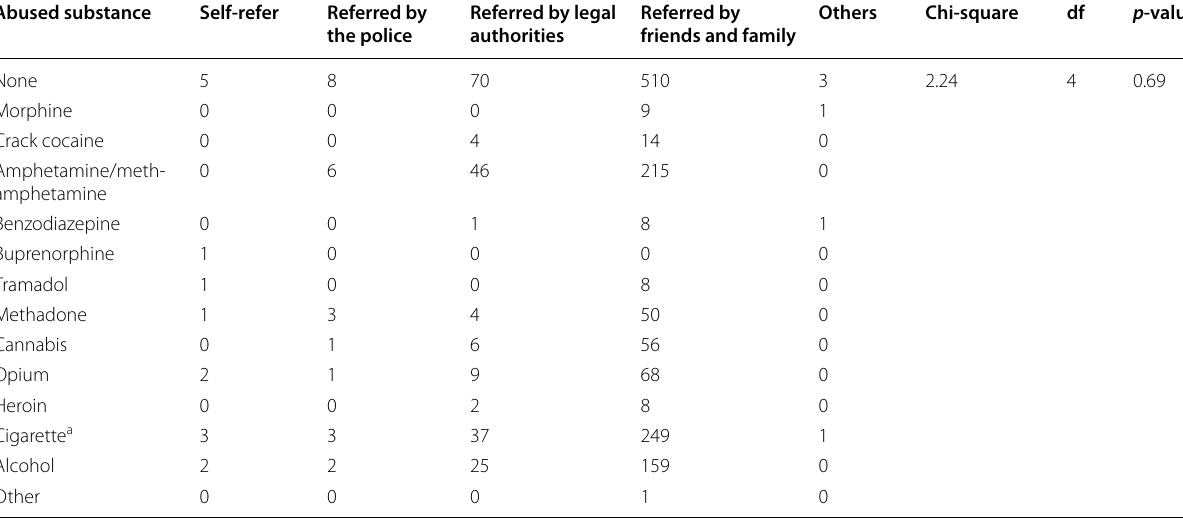
Table 3 Frequency of drug abuse of the patients a